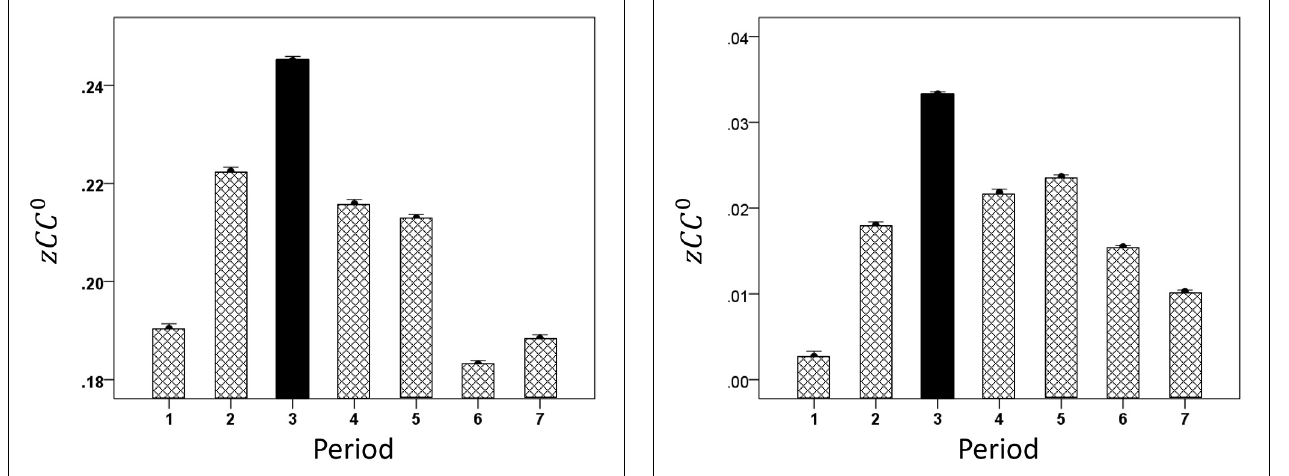
FIGURE 6 | Mean modulation ( ± s.e.m.) of same-hemisphere zCC 0 during task periods, peaking at period 3 (see text for details).